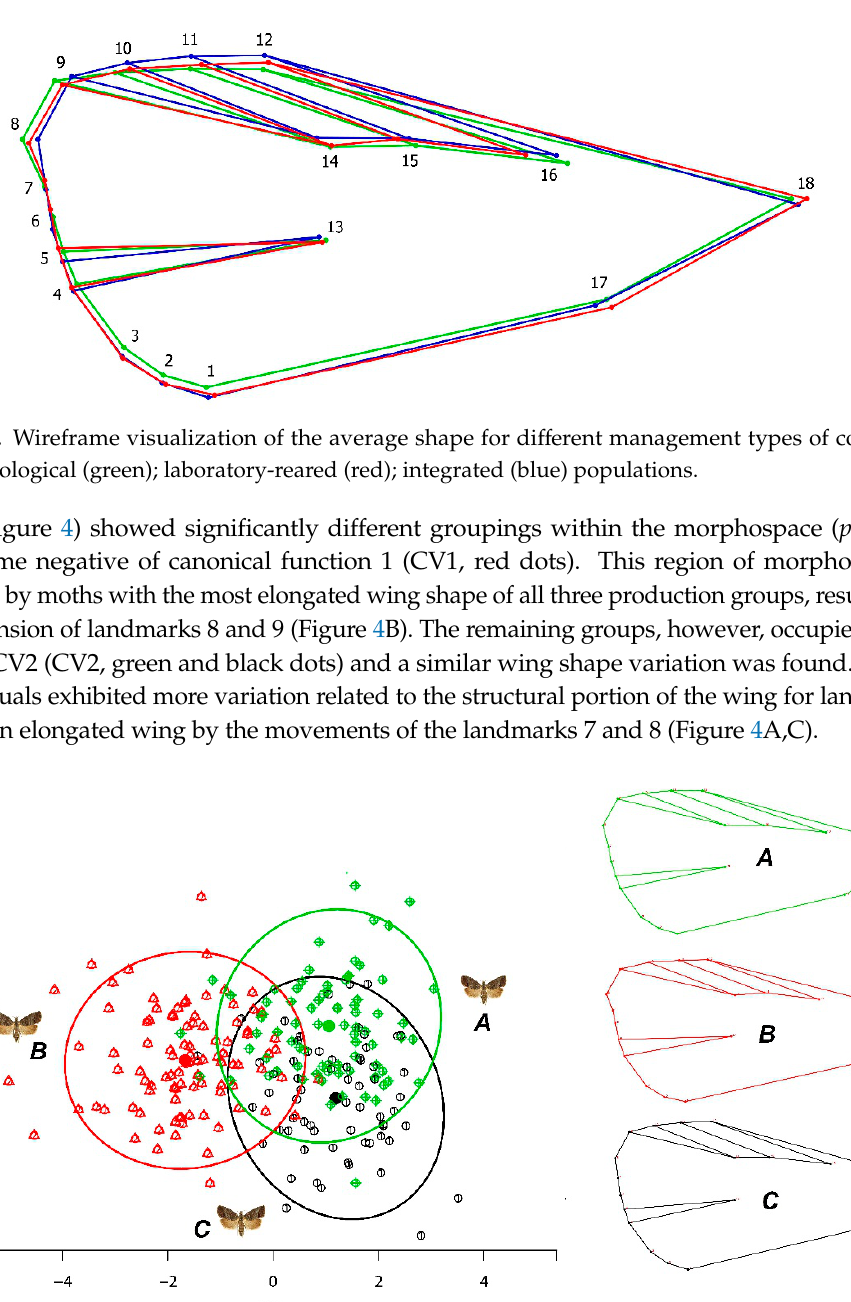
Figure 5. Finite element method-modelled maximum wing deformations (mm) versus wind speed (m/s − 1 ) of the three codling moth treatment populations: ecological (green); integrated (blue); and laboratory-reared (red). These results illustrate that laboratory-reared CM were more sensitive to larger deformations than the ecological and the integrated CM wings (Figure 5). This larger deformation affects CM wing structure to produce a buckling effect on the wing. It was found that wing structure could not withstand loads with its original shape, so that it changed shape to find a new equilibrium configuration. This is an undesirable process and occurred for a well-defined value of the load. The consequences of buckling were geometric and potentially affected CM flight (Figures 6–8).